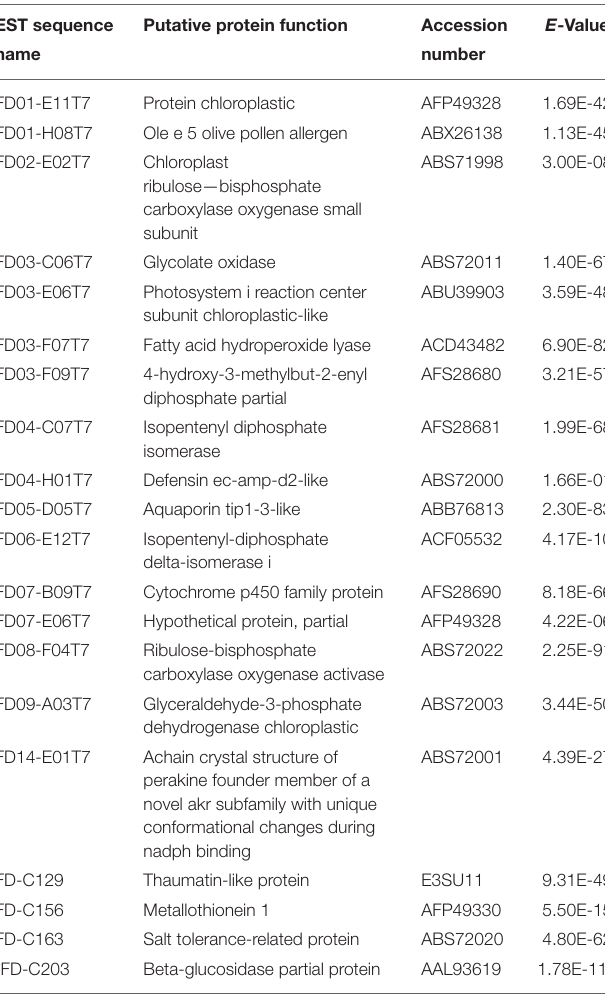
TABLE 3 | List of induced EST sequences identified after Blastx analysis as homologous to olive genes previously indexed in databases. EST sequence Putative protein function